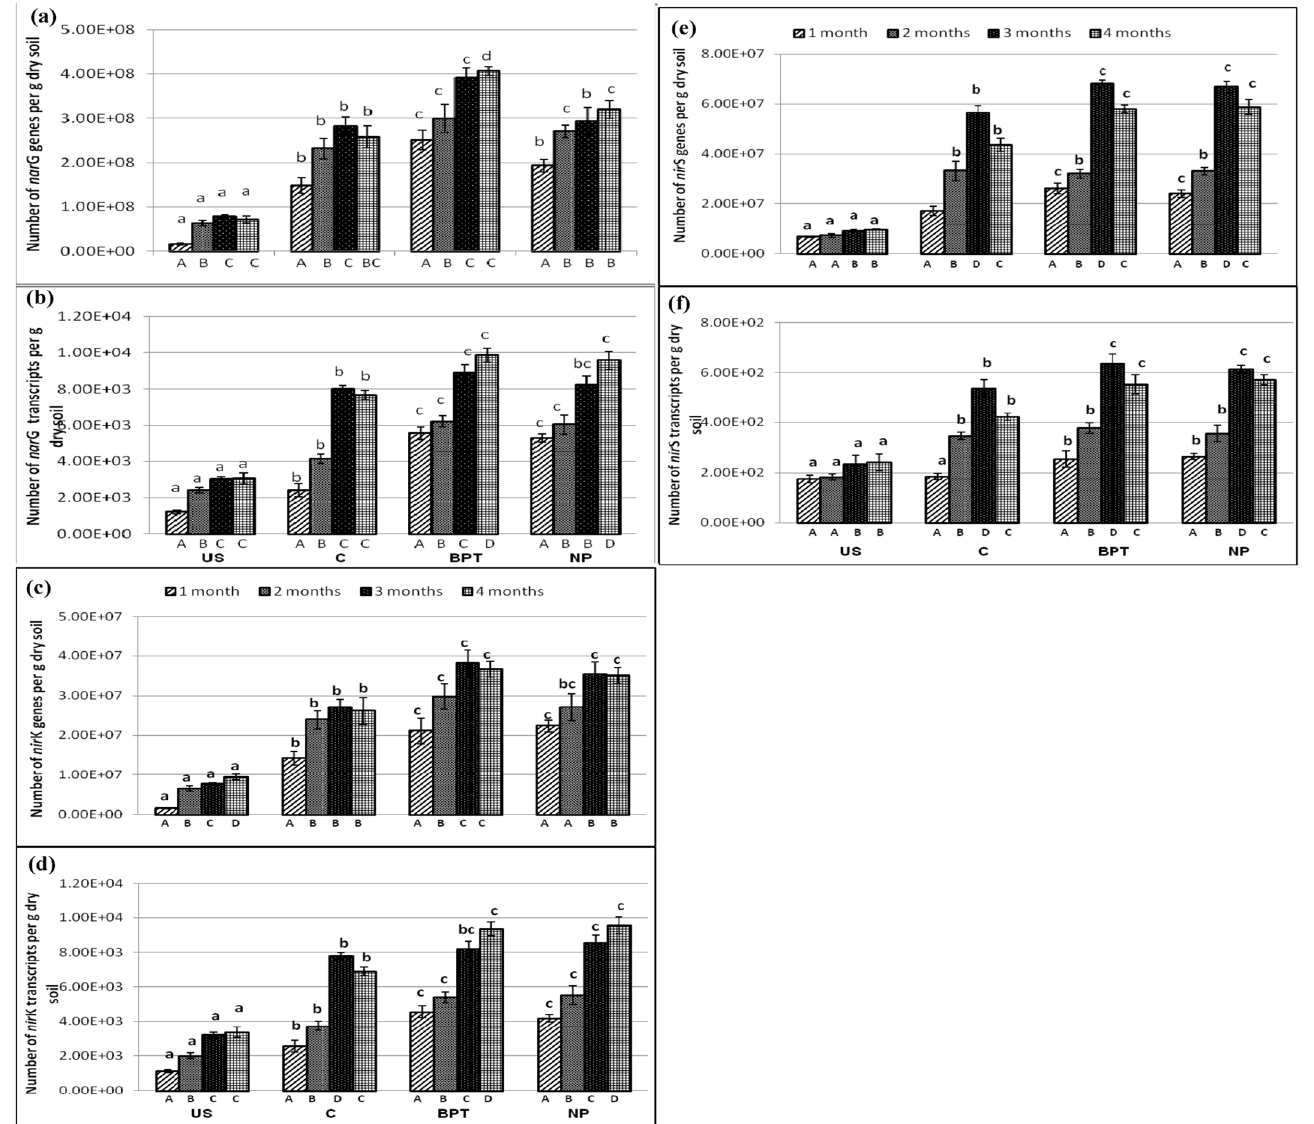
Fig 5. Abundance (copies per g dry soil) of (a) genes and (b) transcripts of membrane-bound nitrate reductase ( nar G); (c) genes and (d) transcripts of Cu- containing nitrite reductase ( nir K); (e) genes and (f) transcripts of cytochrome cd1- containing nitrite reductase ( nir S) under different treatments at four time points. Error bars represent standard deviations ( n = 3). Significantly different values (p < 0.05) between different sampling time points in the same treatment are marked by capital letters (A to D) under the columns, and between different treatments for the same time point are marked by lower case letters (a to